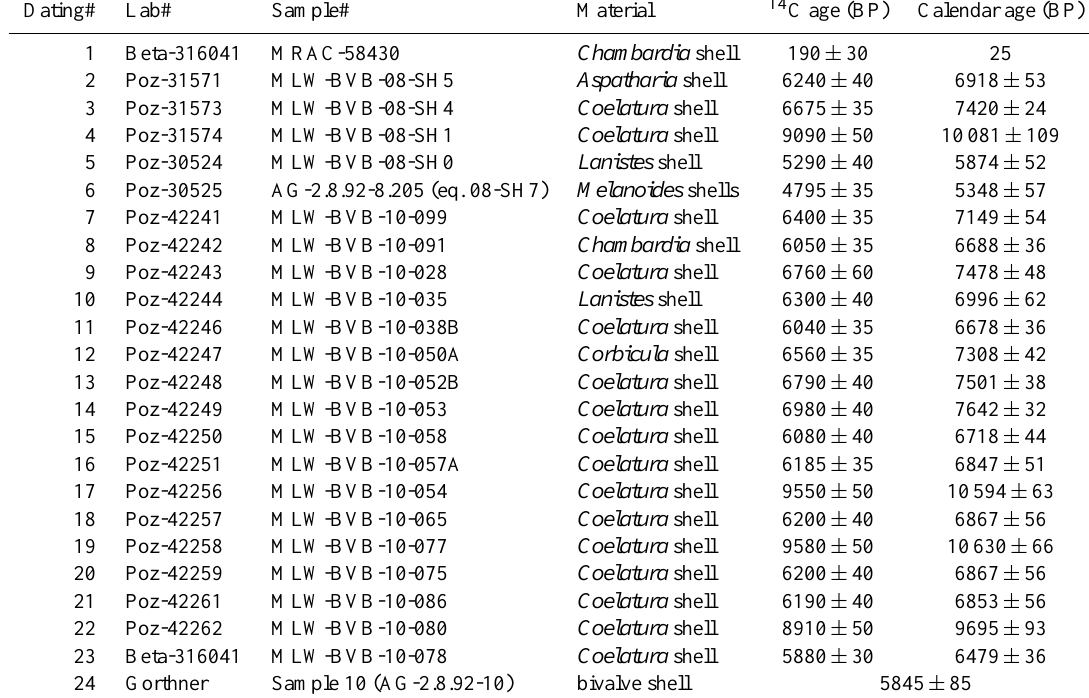
Table 1. Radiocarbon dating results for 23 fossil mollusk samples from the Chipalamawamba Beds and one modern shell. Dating of this modern shell (Dating number 1) resulted in a reservoir effect of ∼ 175yr, which has been used to calibrate the other dates from radiocarbon to calendar age. All MLW-BVB-08 (2008) and MLW-BVB-10 (2010) sample codes are linked to specific shell horizons in Figs. 4 and 5, except for 10-078 and 10-080, which were obtained from outcrops on the eastern shore near